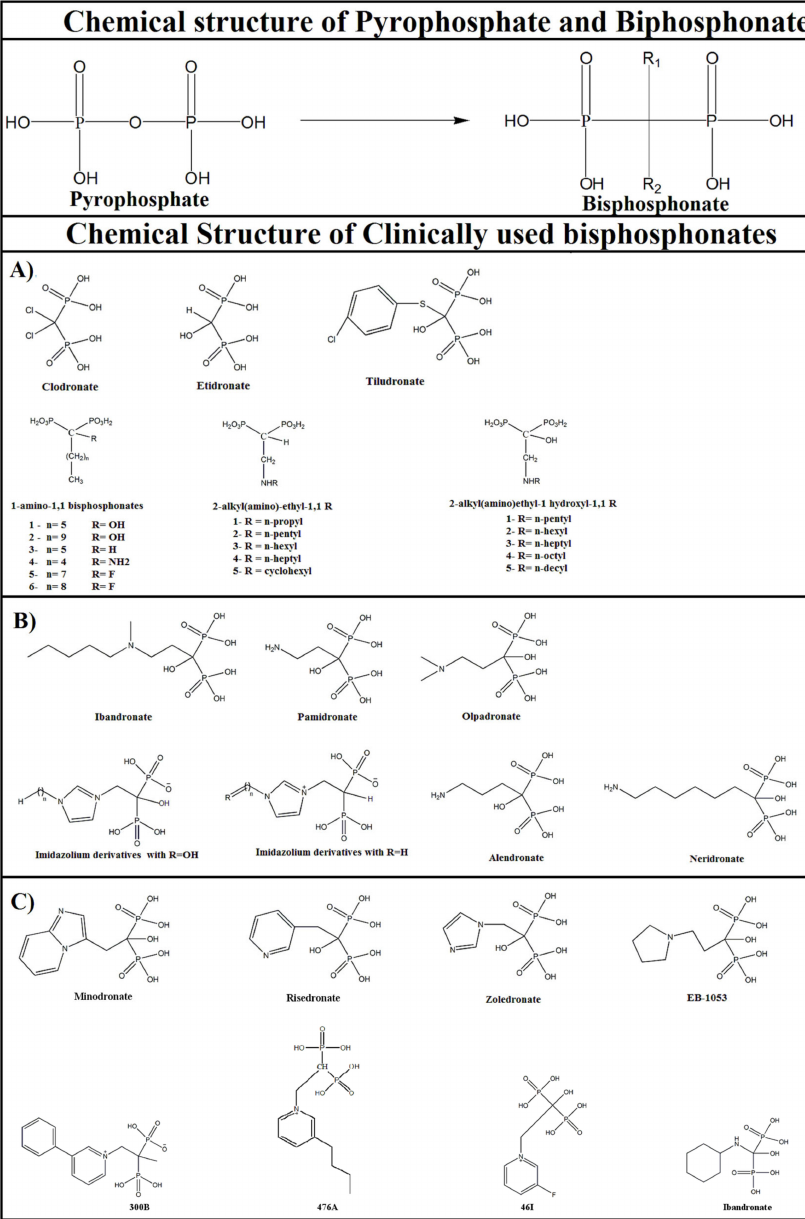
Figure 3. Chemicalstructuresofpyrophosphonate, bisphosphonate, andbisphosphonatesusedclinically[41, 85]. First generation ( A ); second generation ( B ); and third generation of bisphosphonates compounds ( C